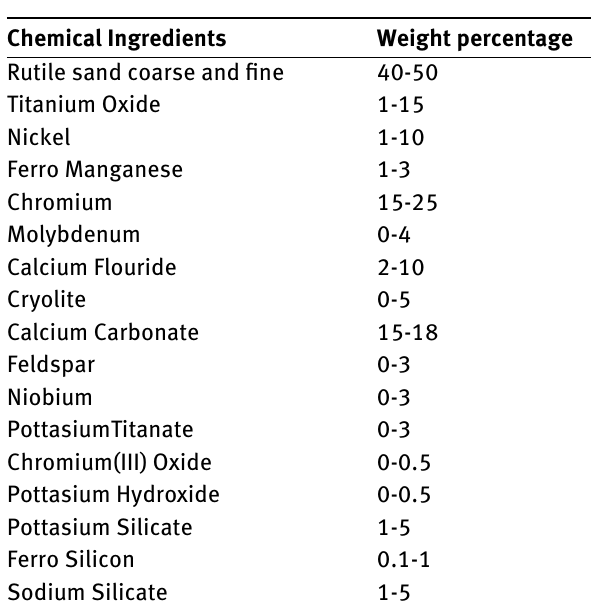
Table 2: Chemical composition of flux